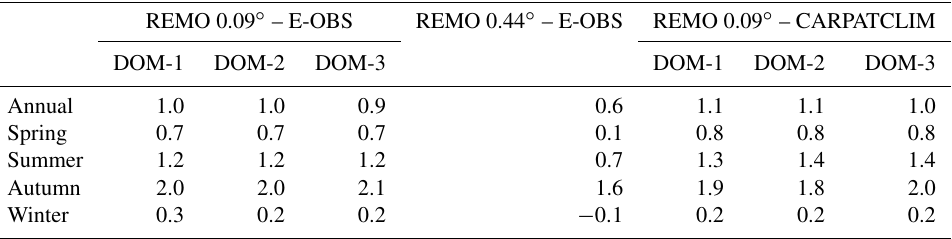
Table 2. Annual and seasonal temperature bias ( ◦ C) between the three model simulations and of REMO_0.44 compared to the E-OBS (first four columns), and between the 10km model simulations and CarpatClim-HU data (last three columns). Temperature data above lakes and rivers is not taken into account in the spatial averages of REMO.